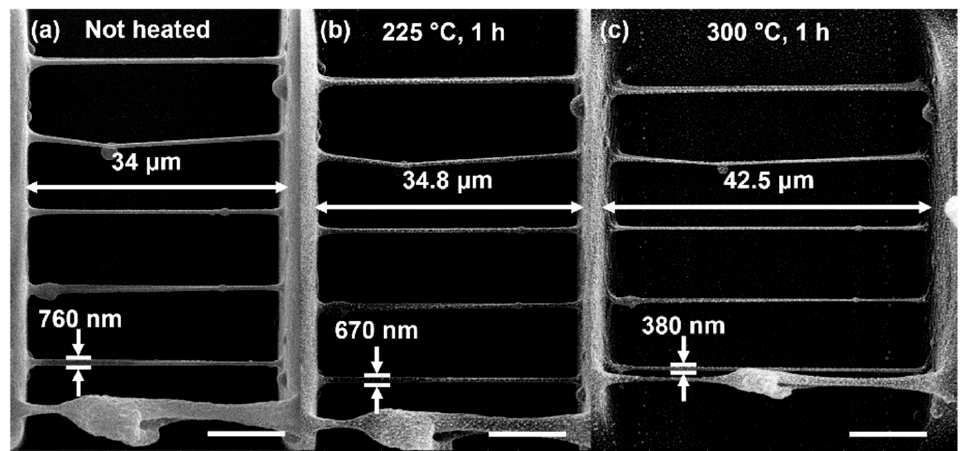
Figure 7. The SEM images of the same RB structure and applied thermal treatment in ambient surrounding: ( a ) before, ( b ) after 1h at 225 °C, ( c ) after additional 1h at 300 °C. It is seen that the structures preserve their shape while downscaling 12% and 50% of their initial dimensions (the line thickness). Scale bar in all images represents 10 µm.